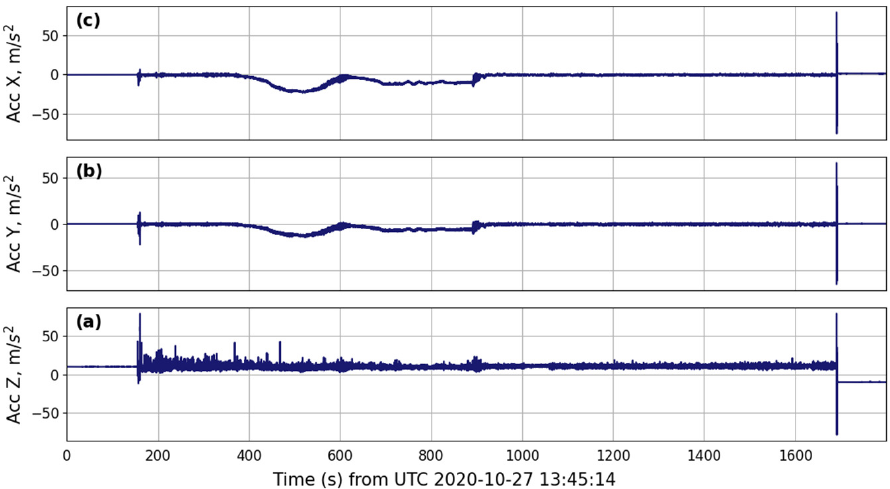
Figure 14. Acceleration channel payload for ( a ) Z-direction component, ( b ) Y-direction component, and ( c ) X-direction component.